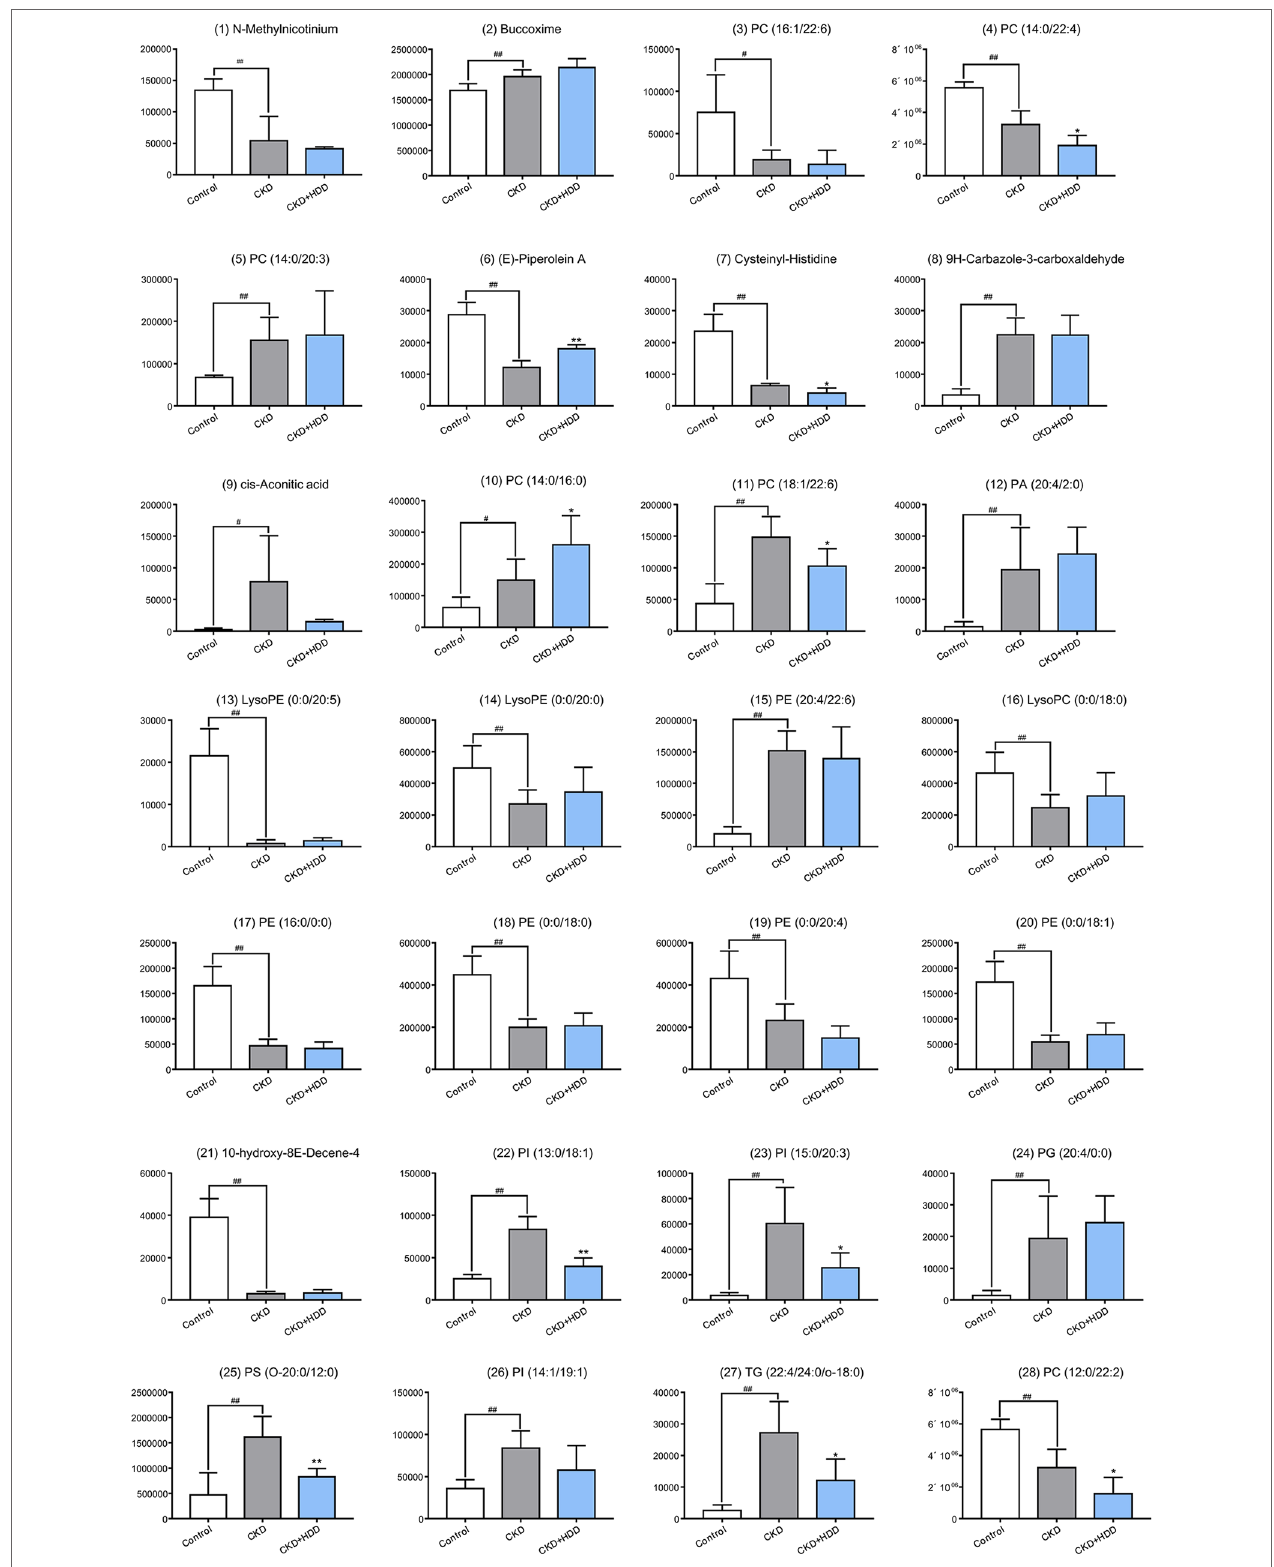
FIGURE 7 | The relative content of 28 metabolites in the control, CKD, and CKD + HDD group. Data are represented as means ± SD, n ≥ 5 rats per group (*P < 0.05, ** P < 0.01 compared with the CKD group; # P < 0.05, ## P < 0.01 compared with the control